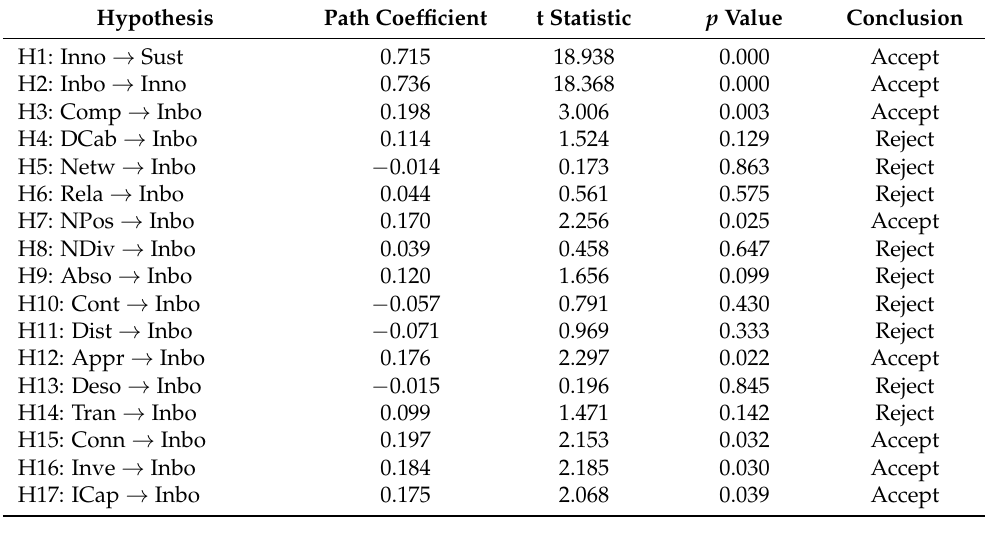
Table 3. Significance of the Structural Model Relationship.